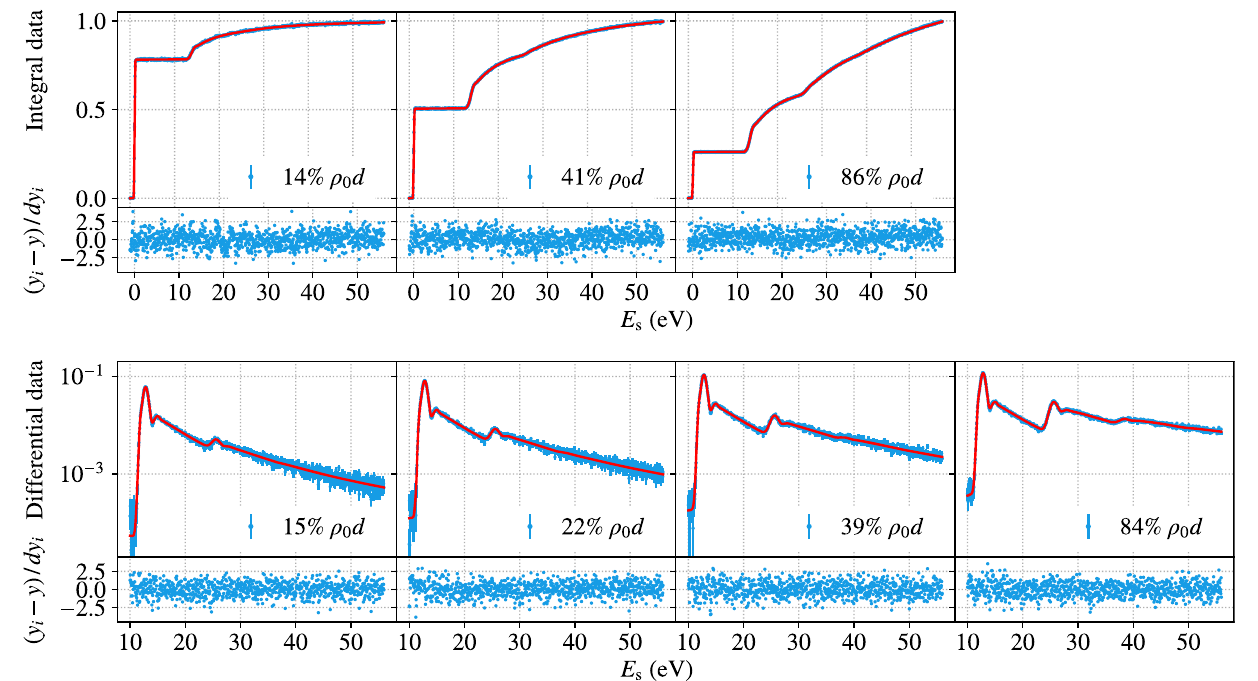
the differential and integral response functions. The differential data is normalized by the total number of counts within the fit range and the integral data by the number of counts in the last